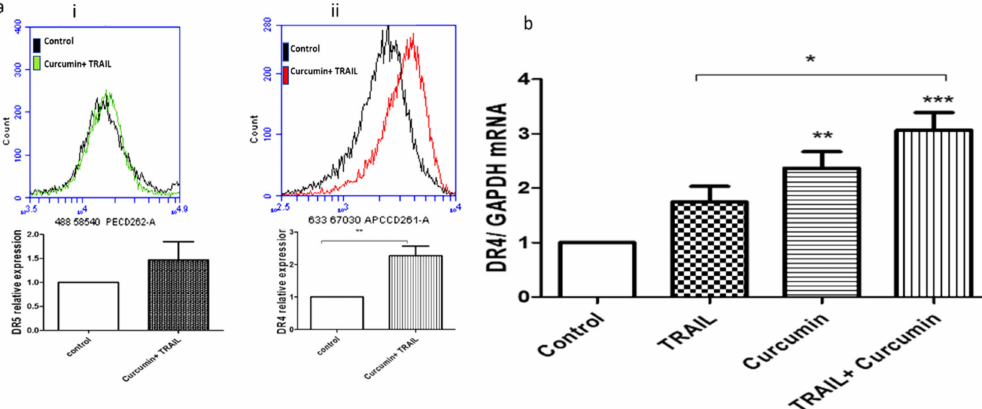
Figure 9. Death receptor 4 upregulation by curcumin / TRAIL combination. ( a ) ACHN cells were cultured on six-well plates and treated with vehicle control or 25 µ M curcumin for 4 h, followed by a further incubation with 50 ng / mL TRAIL for up to 24 h. Cells were incubated with ( i ) APC- or ( ii ) PE-conjugated monoclonal anti-human DR4 and DR5 antibodies, respectively. Independent t-test was used to analyse the data. ( b ) Following cell treatment, RNA was isolated and cDNA was synthesized. qRT-PCR was then performed using a TaqMan-based primer specific to DR4. Results were normalized to GAPDH. The figure is a representative of 3 independent experiments. One-way ANOVA was used to analyse the